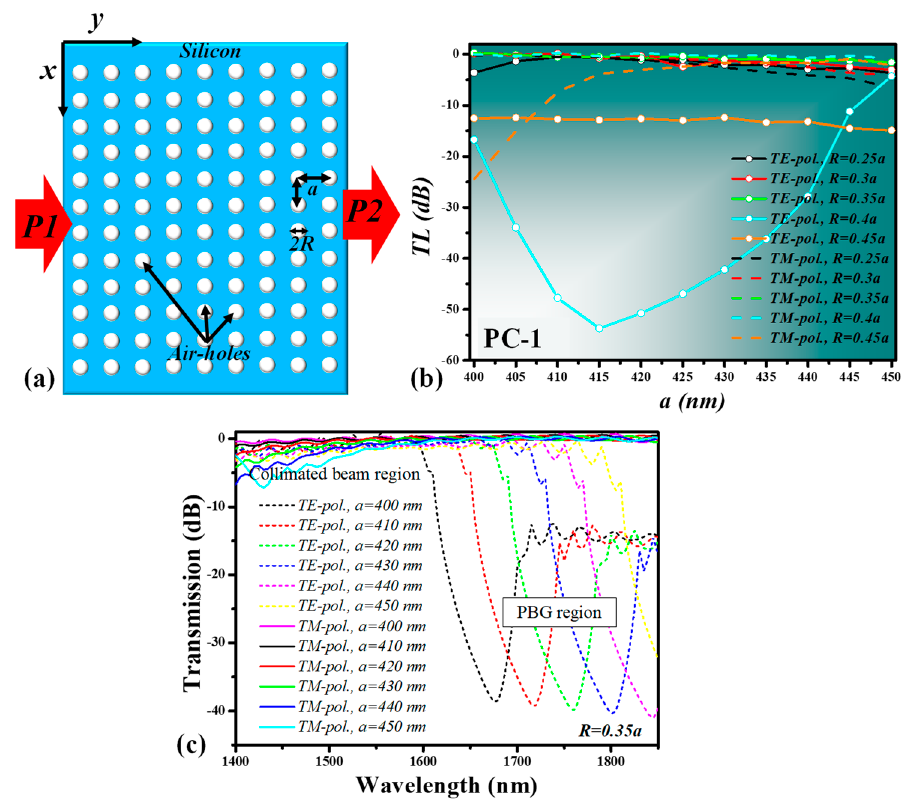
Figure 1. ( a ) Graphical representation of PC-1 formation. ( b ) The TL of TE- and TM-polarized light travelling in PC-1 formation at 1550 nm. ( c ) Transmission of TE- and TM-polarized light for the wavelength range of 1400 to 1850 nm.